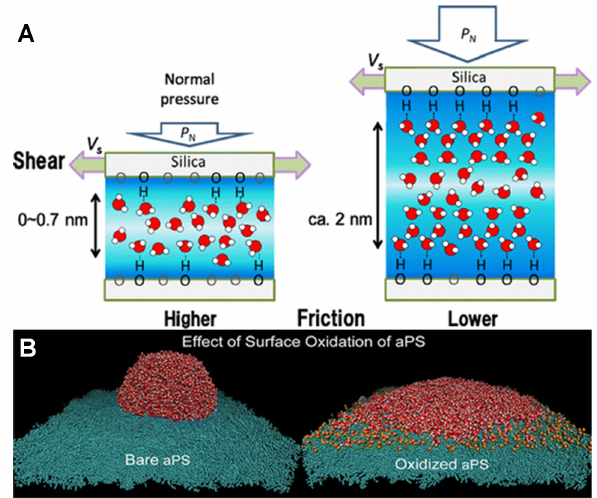
Figure 16. Changes in interfacial water behavior for varying levels of surface oxygen enrichment. ( A ) Shows resonance shear measurements for plasma treated and untreated silica surfaces with differing silanol densities; ( B ) Shows spreading of water on untreated and oxidized atactic Polystyrene. Reprinted with permission from Refs. [160,161], respectively. c (cid:13) 2013 American Chemical